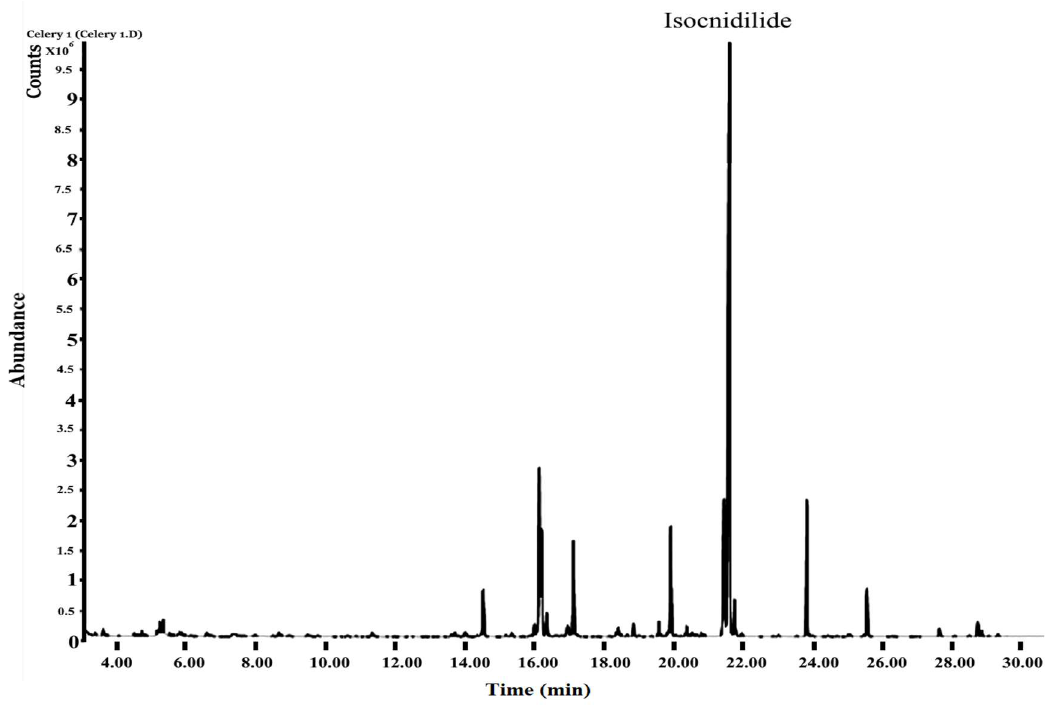
Figure 1. Chromatogram of Apium graveolens oil.